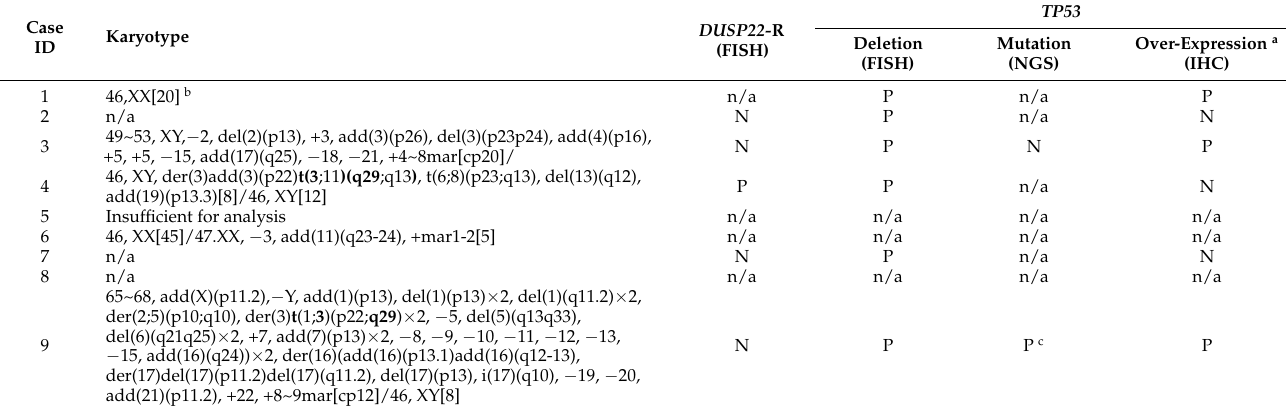
Table 4. Cytogenetic and Molecular Findings of 9 Patients with Leukemic ALK-negative Anaplastic Large Cell